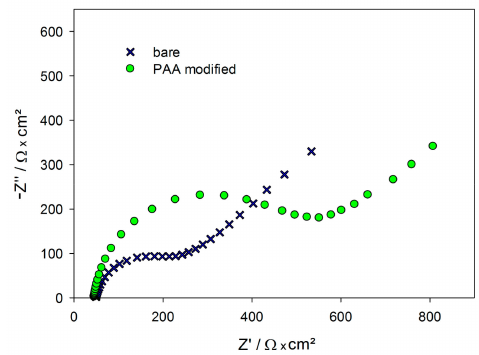
Figure 4. Nyquist plot of the impedance spectra of a blank gold electrode (black crosses) and a PAA/MCH-modified gold electrode (green circles); PAA = protein A-binding aptamer, MCH = 6-mercapto-1-hexanol.